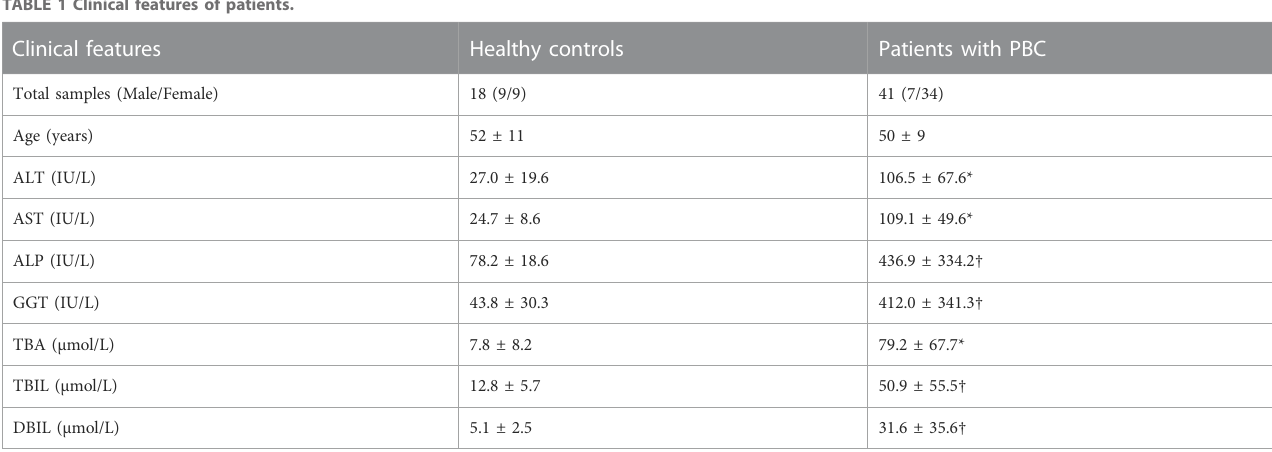
TABLE 1 Clinical features of